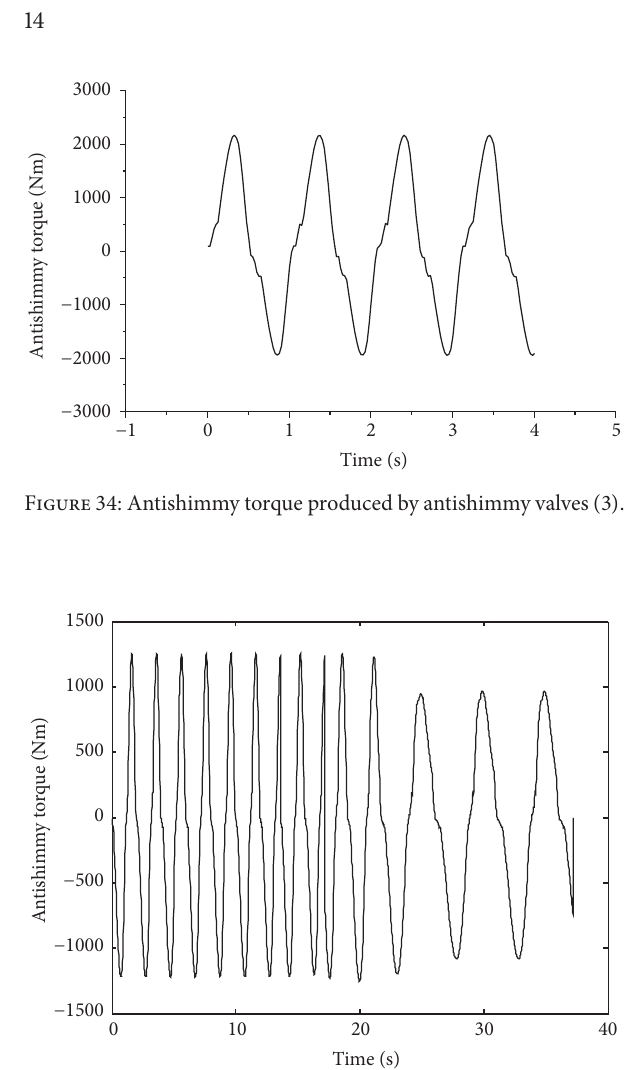
Figure 35: Antishimmy torque affected by shimmy